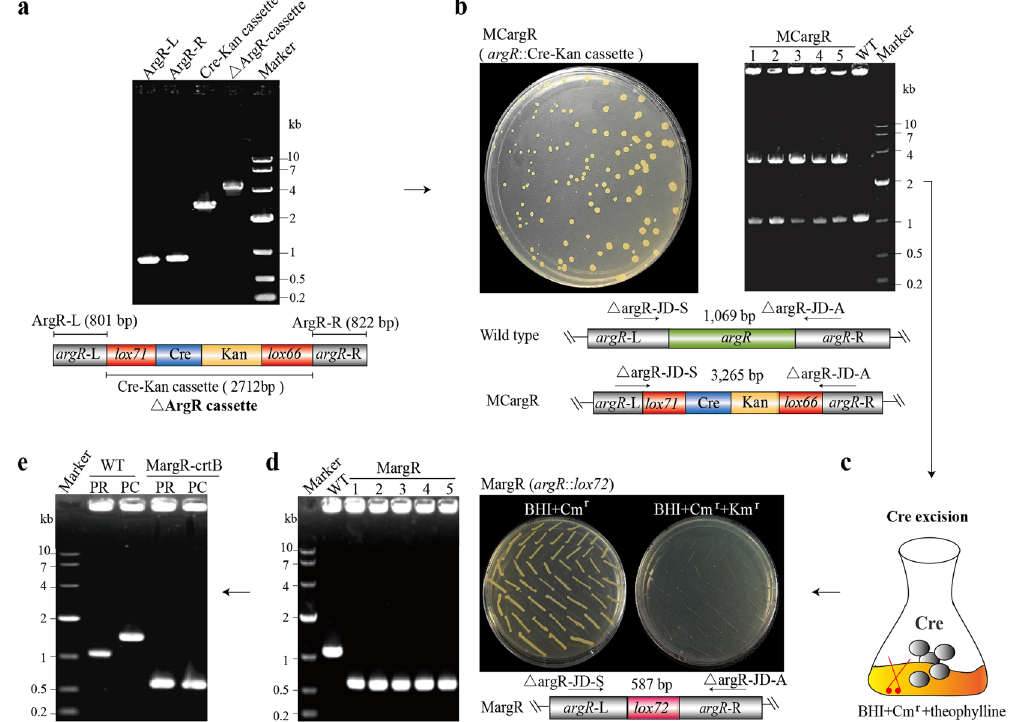
Figure 3. Markerless deletion in C. glutamicum ATCC14067. ( a ) Δ ArgR-cassette construction. The Δ ArgR- cassette contains ArgR-L ( argR homology left and the 34 bp lox71 sequence), Cre-Kan cassette and ArgR-R (34 bp lox66 sequence and argR right homology). ( b ) Δ ArgR-cassette recombineering with RecET. The primer pairs of Δ argR-JD-S/A were used for the verification of colony PCR. WT is C. glutamicum ATCC14067. ( c ) Cre excision by the addition of 1 mM theophylline: at least four recombinants were used to evaluate the excision efficiency. ( d ) Identification markerless deletion of the argR gene. MargR represents the strain in which the argR gene is replaced by the 34 bp sequence of lox72 . ( e ) Identification markerless deletion of the crtB gene in MargR. MargR-crtB represents the strain in which the argR and crtB genes are replaced by the sequence of 34 bp lox72 . PR is the Δ argR-JD-S/A primer pair. PC is the Δ crtB-JD-S/A primer pair. All primers are listed in